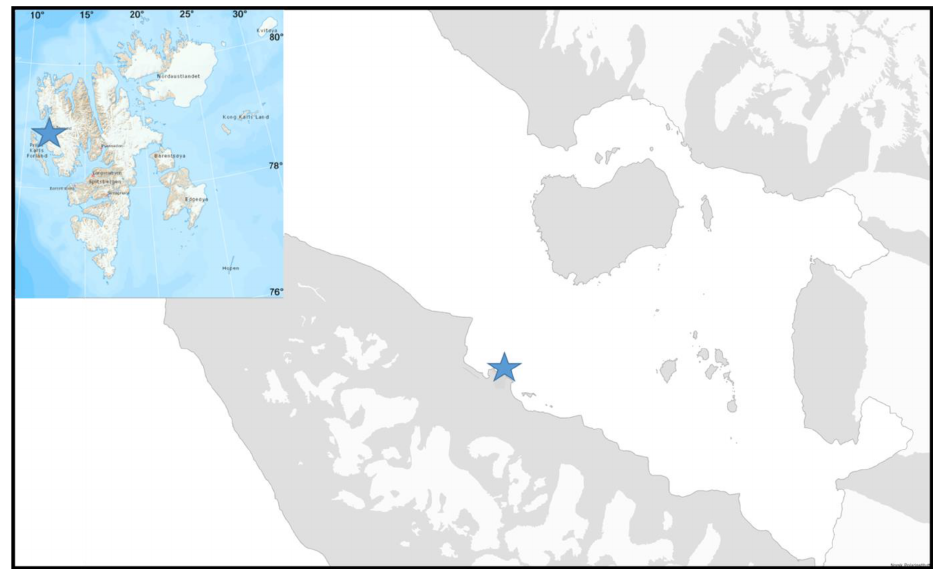
Figure 1. Spitzbergen with Kongsfjorden ( ( ) in the small inlay panel in the upper left corner) and the location of NyÅlesund in Kongsfjorden ( ( ) ). Source: Norwegian Polar Institute (2014),